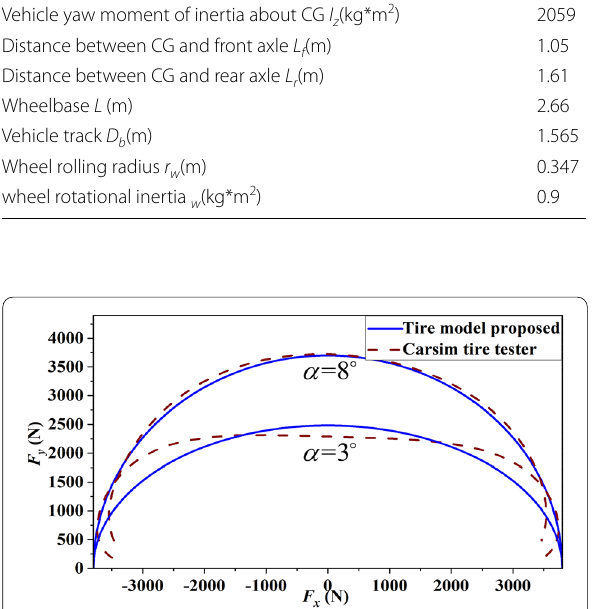
Figure 5 Tire forces from the proposed tire model and the CARSIM Tire